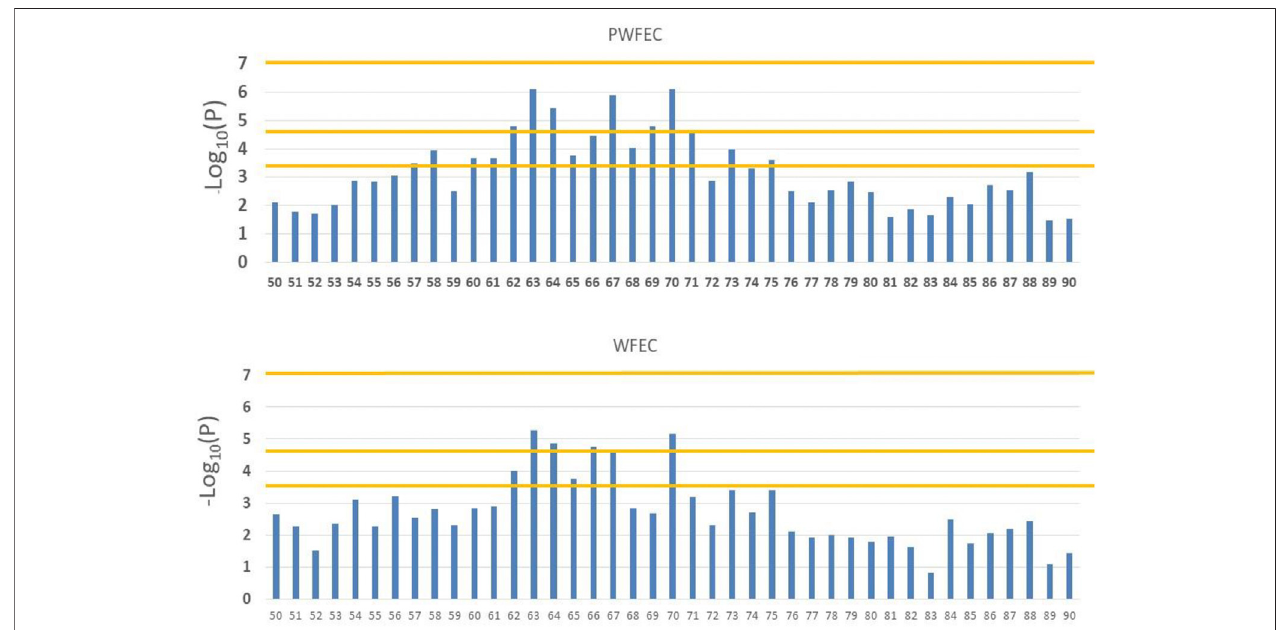
FIGURE3| ManhattanplotsforassociationsbetweenSNPinbins50through90onchromosome5andweaning(WFEC)andpostweaning(PFEC)fecaleggcount EBV. Horizontal lines indicate chromosome-wide signi fi cance with 2,540 bins (bottom line), genome-wide signi fi cance with 2,540 bins (middle line), and genome-wide signi fi cance with 458,625 SNP (top line).